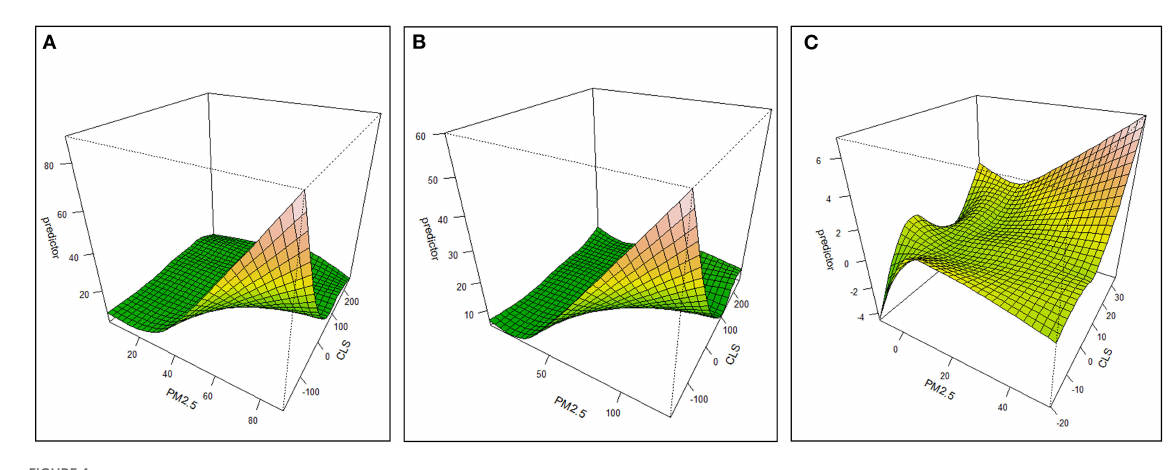
leading cause of mortality (49,